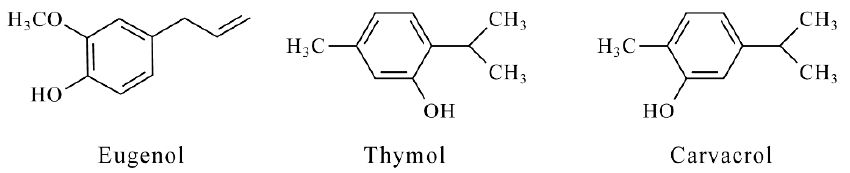
Figure 2. Structure of the main phenolic antioxidants of essential oils. Terpenes and their derivatives (Figure 3) interact with electrogenerated bromine via its electrophilic addition to double